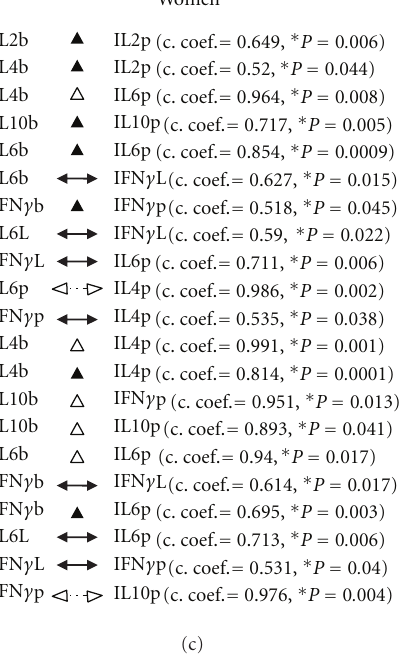
Figure 1: Relationships using the whole blood assay method (72h assay, black): (black triangle) Positive relationships. Relationships using PBMC cells separated by Ficoll/Hypaque gradient procedures (24 h assay, white): (white triangle) positive and (crescent shape) negative relationships. Basic Condition: resting state; +LPS: APC activated condition; +PHA: T cell activated condition. Basic condition (b), LPS (L), PHA (p). In healthy subjects, di ff erences in the relationships in the “level network profiles” could be responsible for the sexual dimorphism of the immune response in health. Gender-specific relationships in “level network profiles” a ff ect the direction (Th1 or Th2) of the immune response under resting (Basic) and activated (+PHA) conditions. APCs ( +LPS ) regulate the starting type and evolution of immunological responses in both men and women: the starting type (+LPS → Basic,) appears to be regulated by IFN γ production in men, and by IL6